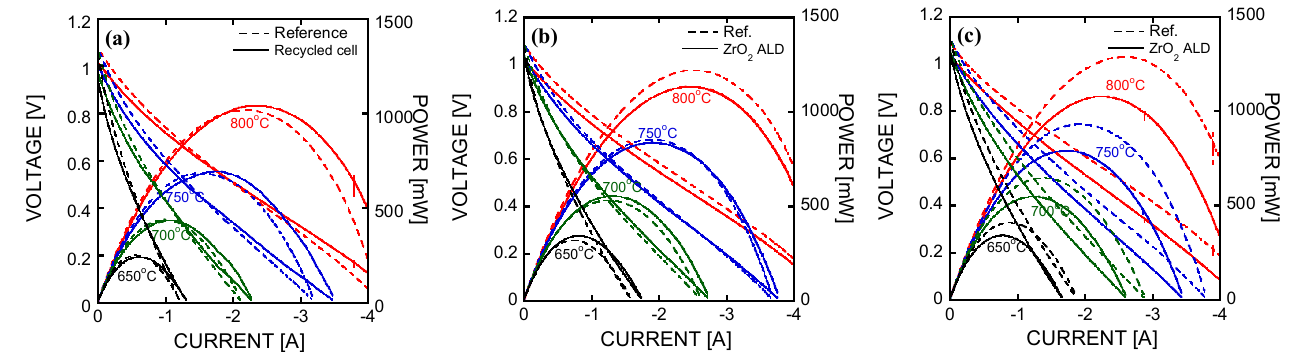
Figure 11. Open cell voltages and current–voltage characteristics: ( a ) no PEALD of ZrO 2 , ( b ) PEALD ZrO 2 with 50 cycles, and ( c ) PEALD ZrO 2 with 200 cycles.